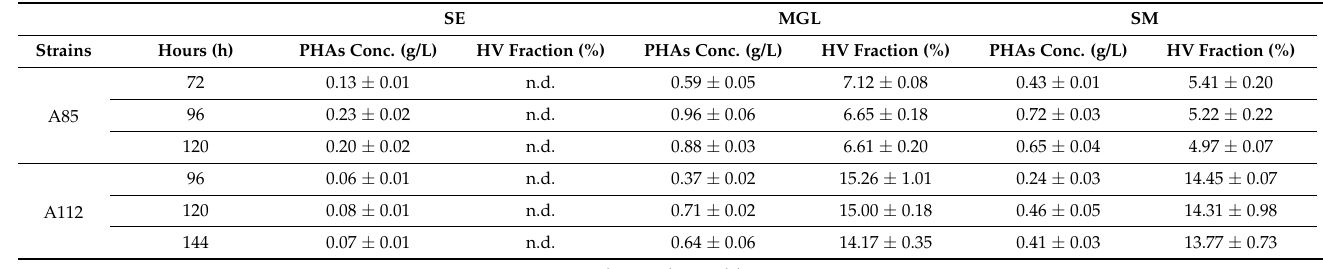
Table 3. PHA accumulation of haloarchaeal strains in different carbon source mediums.